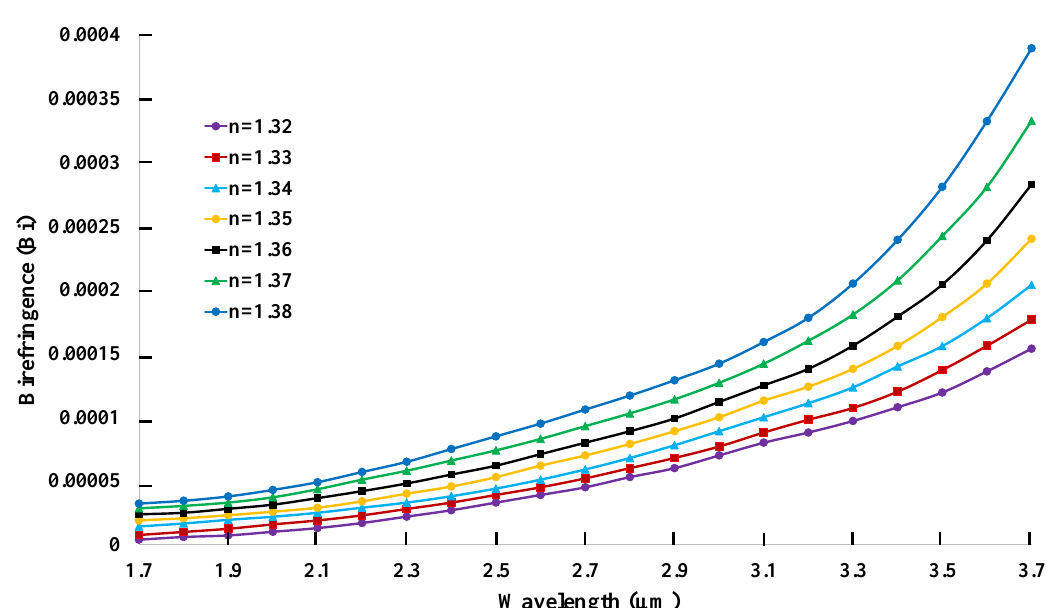
Figure 3. The birefringence curve of the proposed C-PCF structure versus